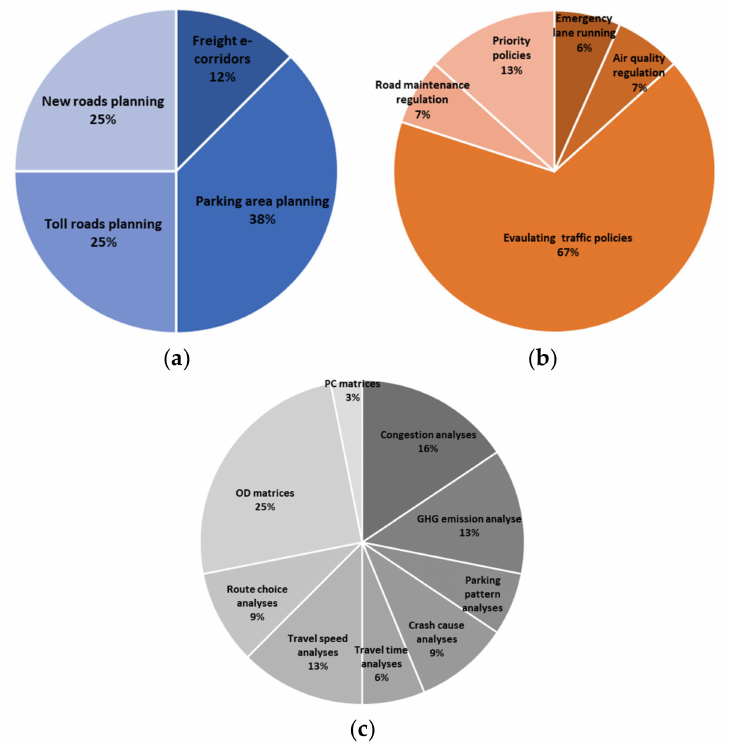
Figure 4. Distributions of the identified articles in categories of infrastructure-planning ( a ), freight movement regulations ( b ), and freight data analyses ( c